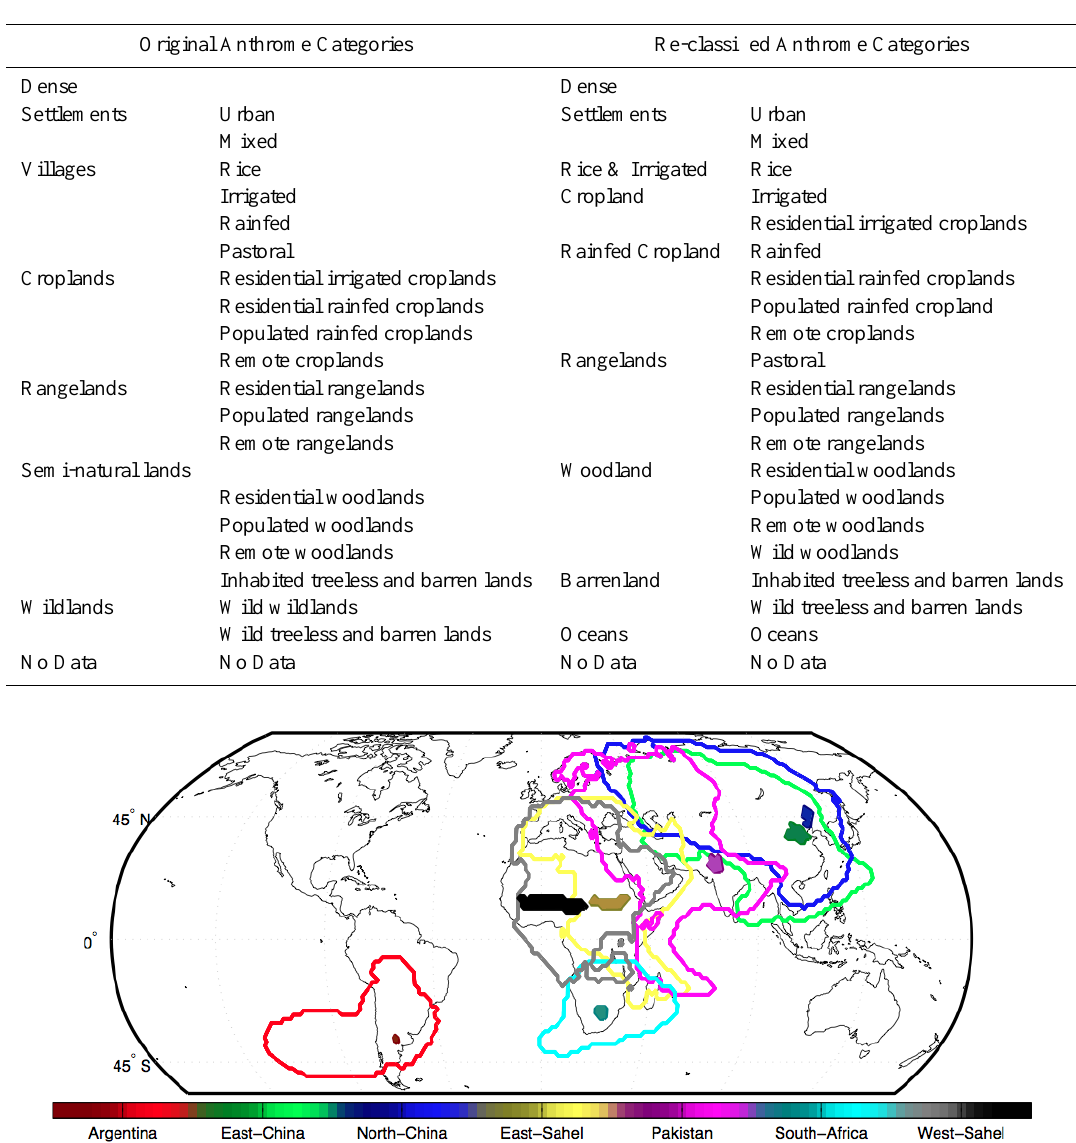
Table 2. This table depicts the re-classification of the Anthromes 2.0 categories based on general land cover characteristics (Ellis et al., 2010).